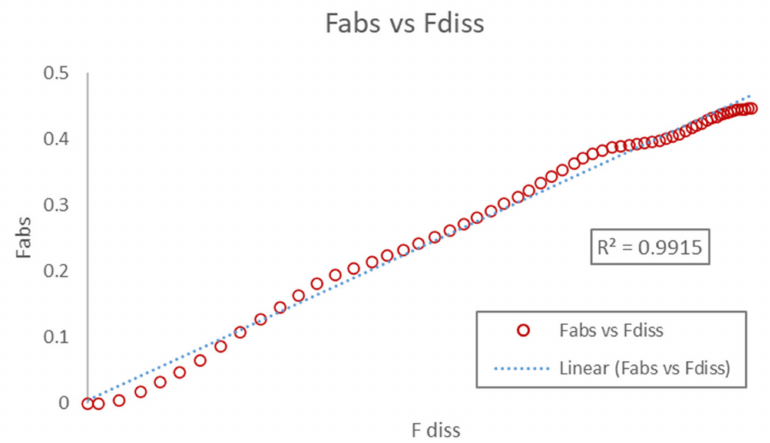
Figure 9. Calculated absorption after deconvolution of Xarelto 20 mg tablet.